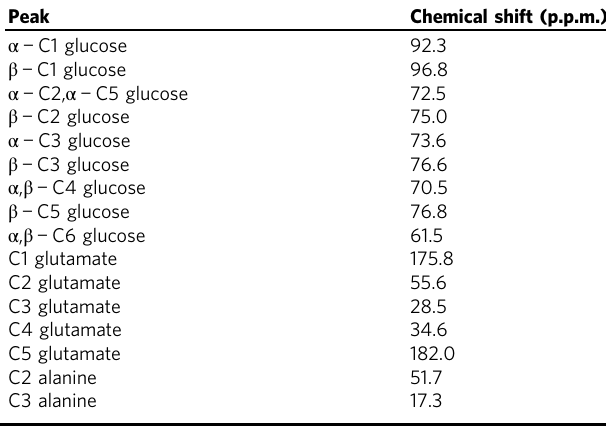
Table 4 Calculation of hepatic mitochondrial fl uxes (V PC , V CS ) with PINTA